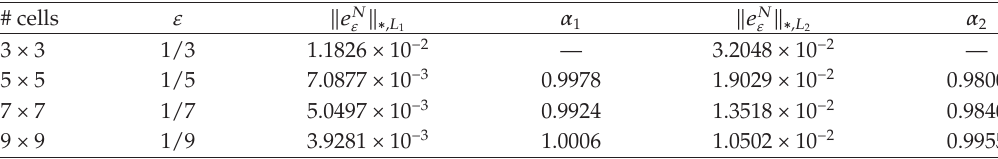
Table 4: Comparison of the macro-model to the micro-model for di ff erent values of ε Example 3.5. # cells ε (cid:10) e N